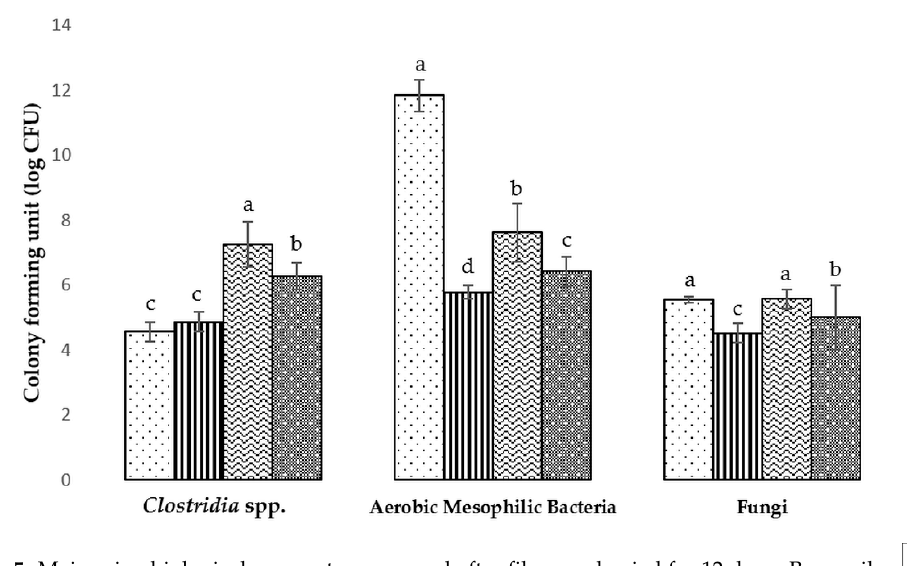
Figure 5. Main microbiological parameters assessed after film was buried for 12 days. Bare soil = ; Mater-Bi = ; protein-based film from black soldier fly prepupae = ; polyethylene = . Whiskers indicate the standard deviation interval, while bars with the same letter do not significantly differ at p < 0.05. The statistical differences were tested only between the different treatments at each time point.